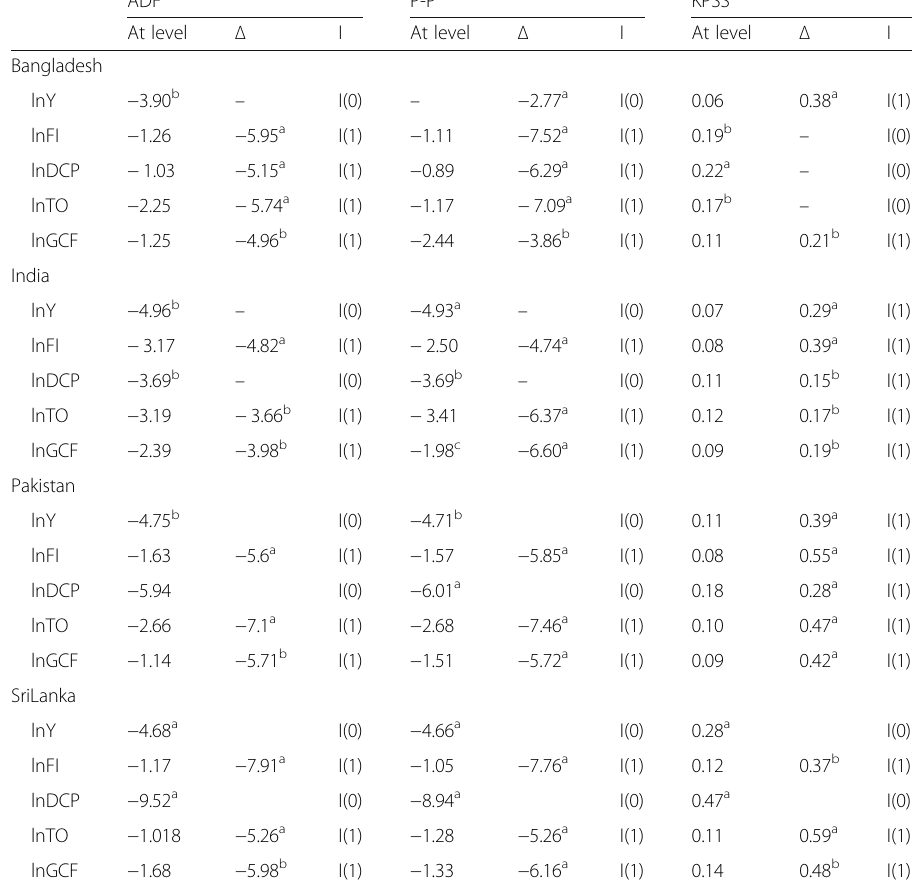
Table 2 Unit root test